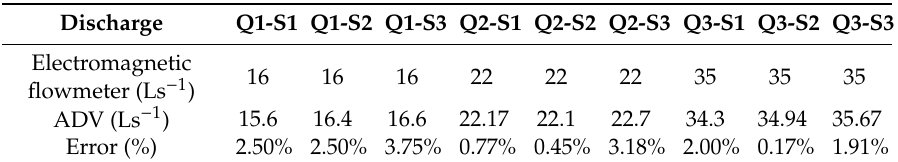
Table 2. Instrument measurement